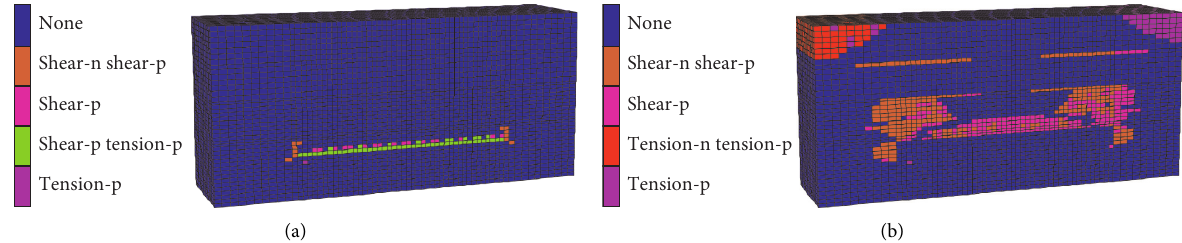
Figure 14: Plastic zone of overburden failure. (a) Mining thickness of one layer, 3m. (b) Mining thickness of five layers, 15m.